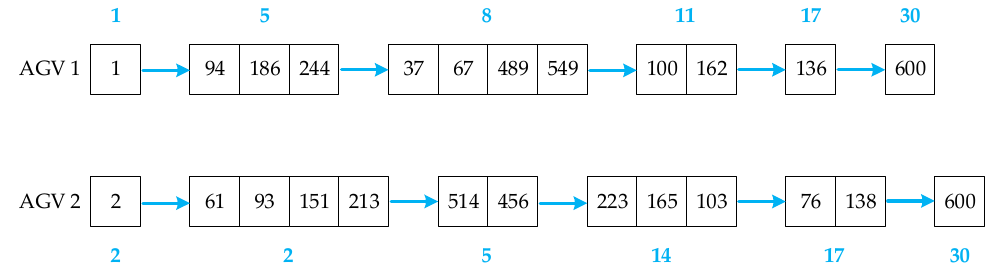
Figure 6. Grouping results for two AGVs’ picking sequences in which every group is separated by an arrow.